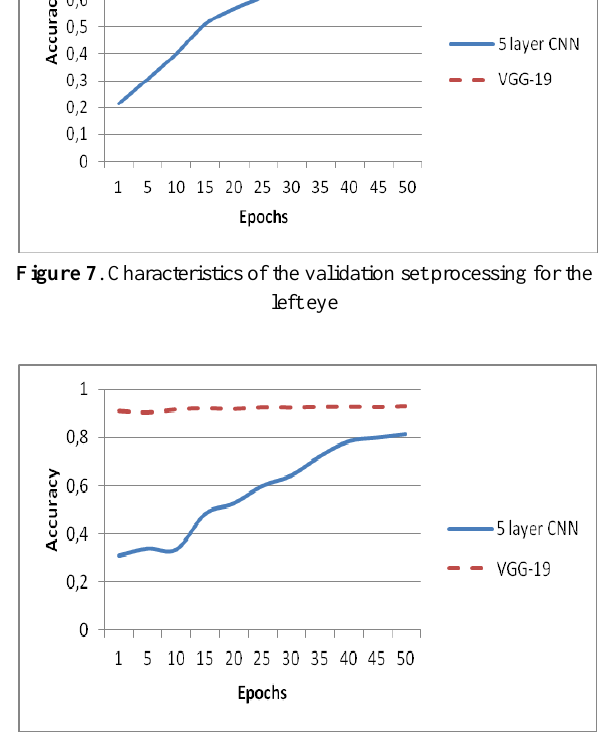
Figure 8 . Characteristics of the validation set processing for the right eye